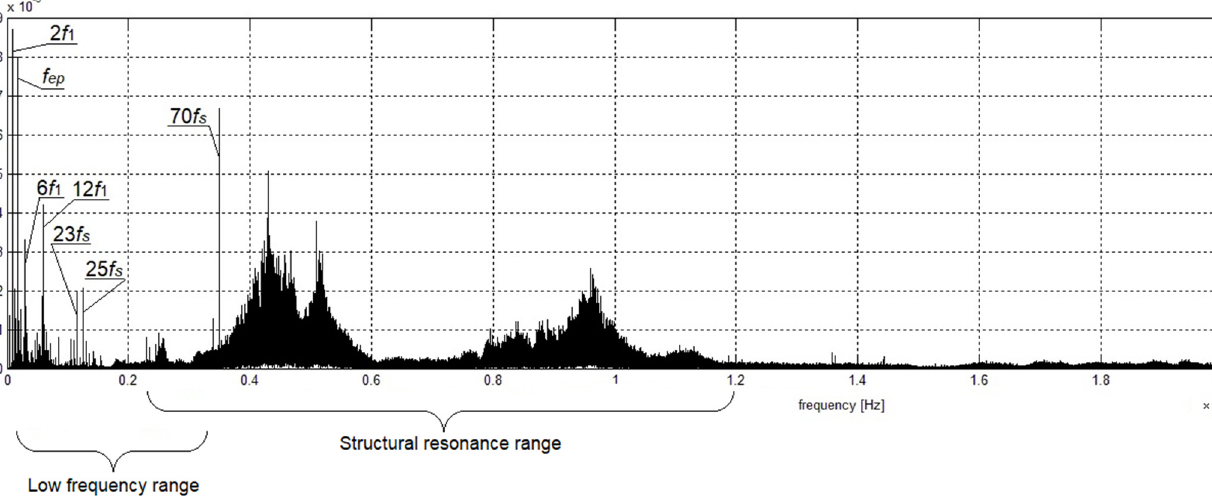
Figure 11. Frequency spectrum of vibration acceleration of the outer casing of the motor with a bearing slackness. The dominant frequency components of vibrations are marked.